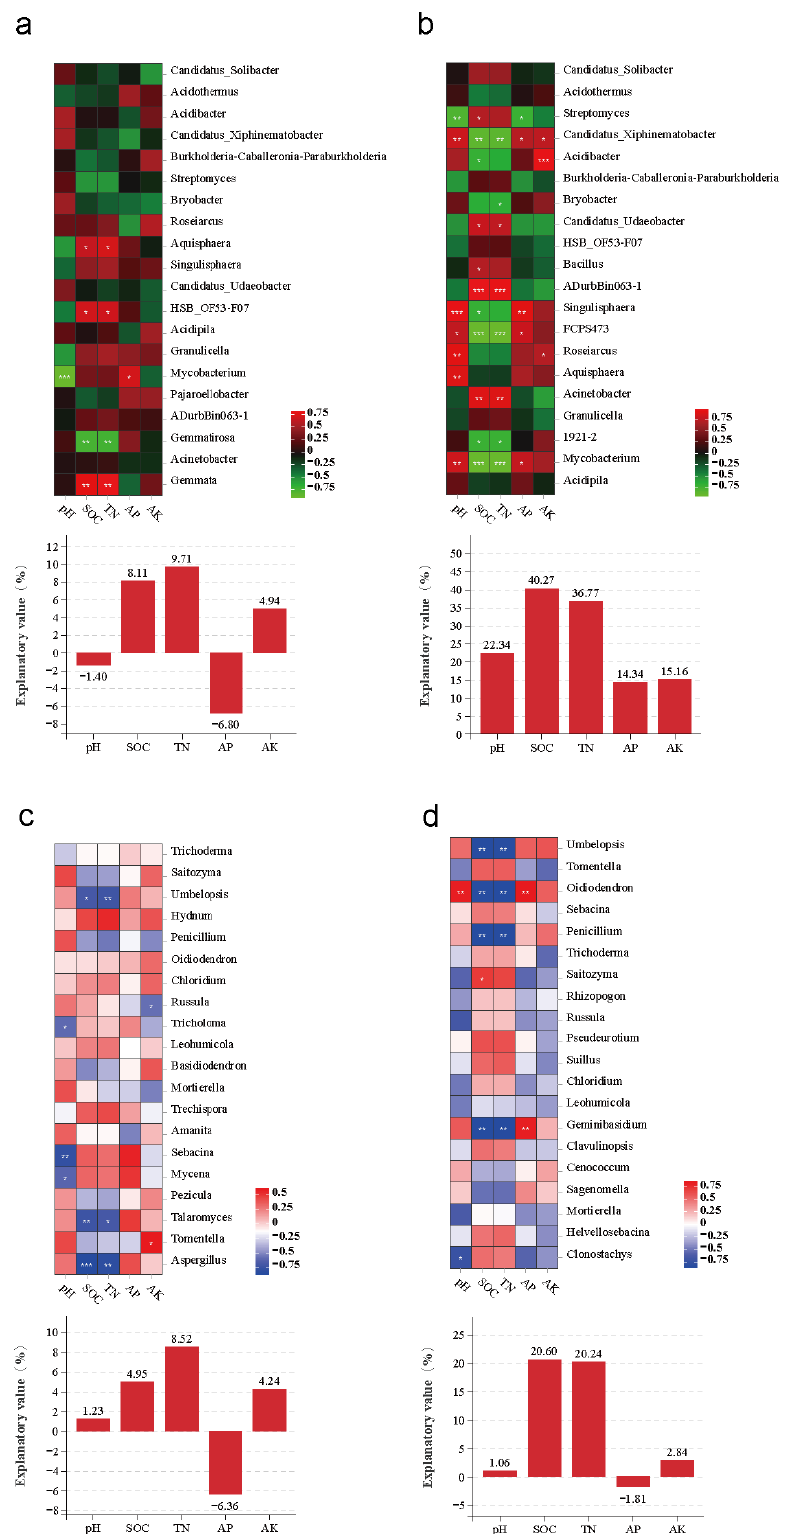
Figure 7. Pearson’s rank correlation coefficients between soil properties and the dominant (relative abundance) bacterial genera in P. taiwanensis ( a ) and P. massoniana ( b ) and fungal genera in P. taiwa- nensis ( c ) and P. massoniana ( d ) forest soils. SOC, soil organic carbon; TN, total nitrogen; AP, available phosphorus; AK, available potassium. The colors represent positive and negative correlations (red: positive; green and blue: negative), and the numbers represent correlation coefficients. *** ( p < 0.001); ** ( p < 0.01); * ( p <